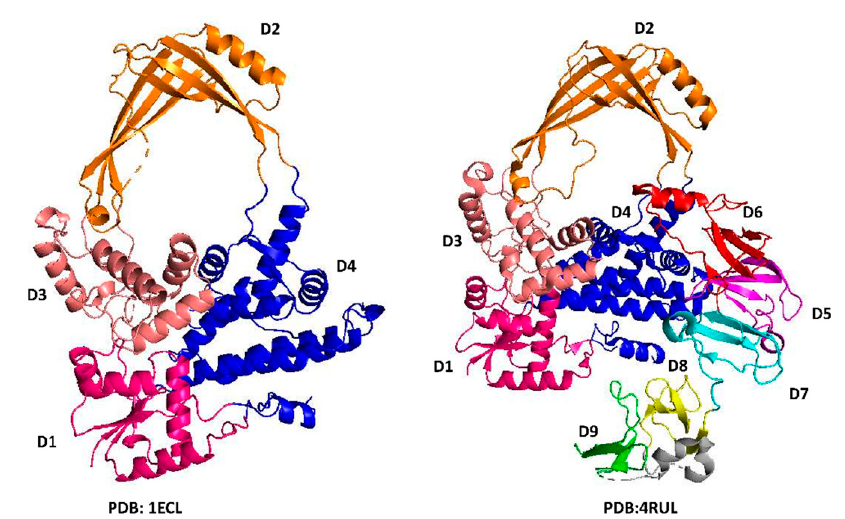
Figure 2. Domain arrangement in E. coli topoisomerase I as seen in the crystal structure of the N-terminal core domains (PDB 1ECL) or full-length enzyme (PDB 4RUL). D1: amino acids 4–36, 81–157 colored in pink; D2: amino acids 216–278,405–472 colored in orange; D3: amino acids 279–404 colored in salmon; D4: amino acids 61–80,158–215,473–590 colored in blue; D5: amino acids 591–635 colored